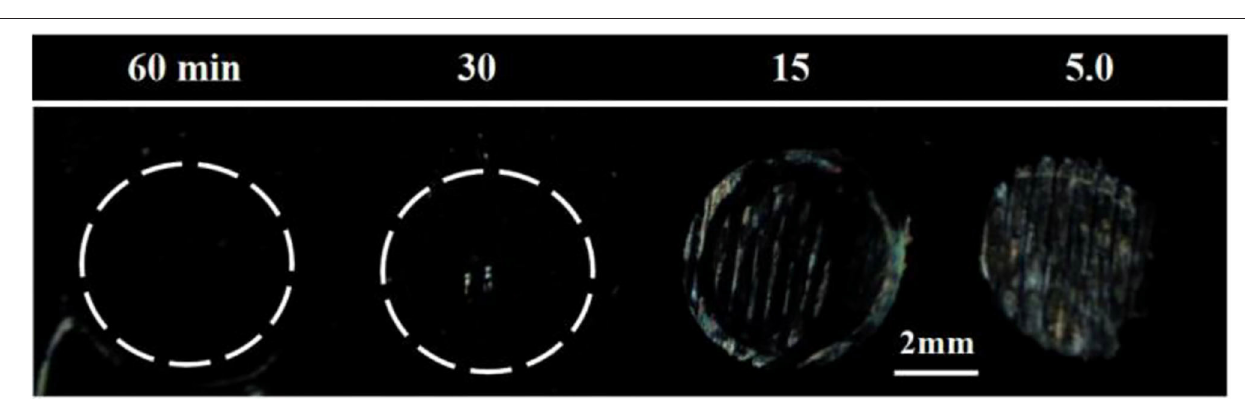
FIGURE 4 | Effect of incubation time on removal of surface-immobilized gp-120. Optical images of LC supported on DMOAP coated glass slide decorated with gp-120 patterns after incubation in a B40t77 solution (16 µ g/ml) for different incubation times (60, 30, 15, and 5min).